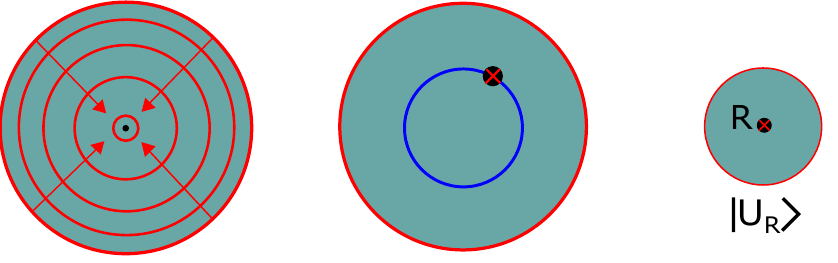
Figure 9 . Left: disk slicing as concentric circles in the character Hilbert basis. Middle: intersecting Wilson line operators. Right: state-operator correspondence associating a (cid:12)xed holonomy state j U (cid:21) i to a local puncture in the representation R